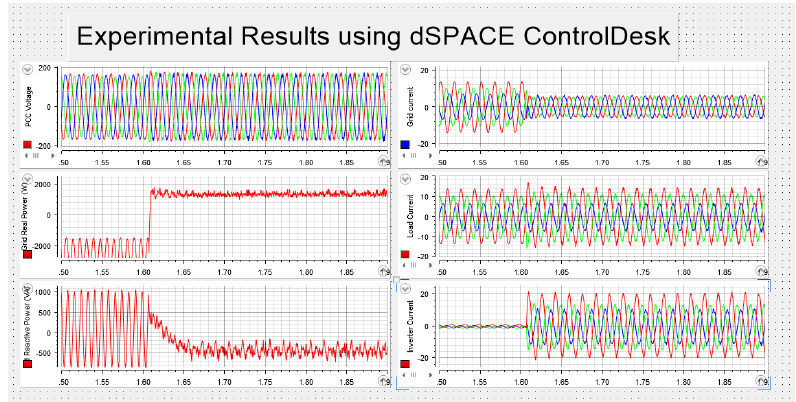
Figure 18. Experimental results at P = 1.5 kW, Q = − 500 var, using dSPACE Control desk.